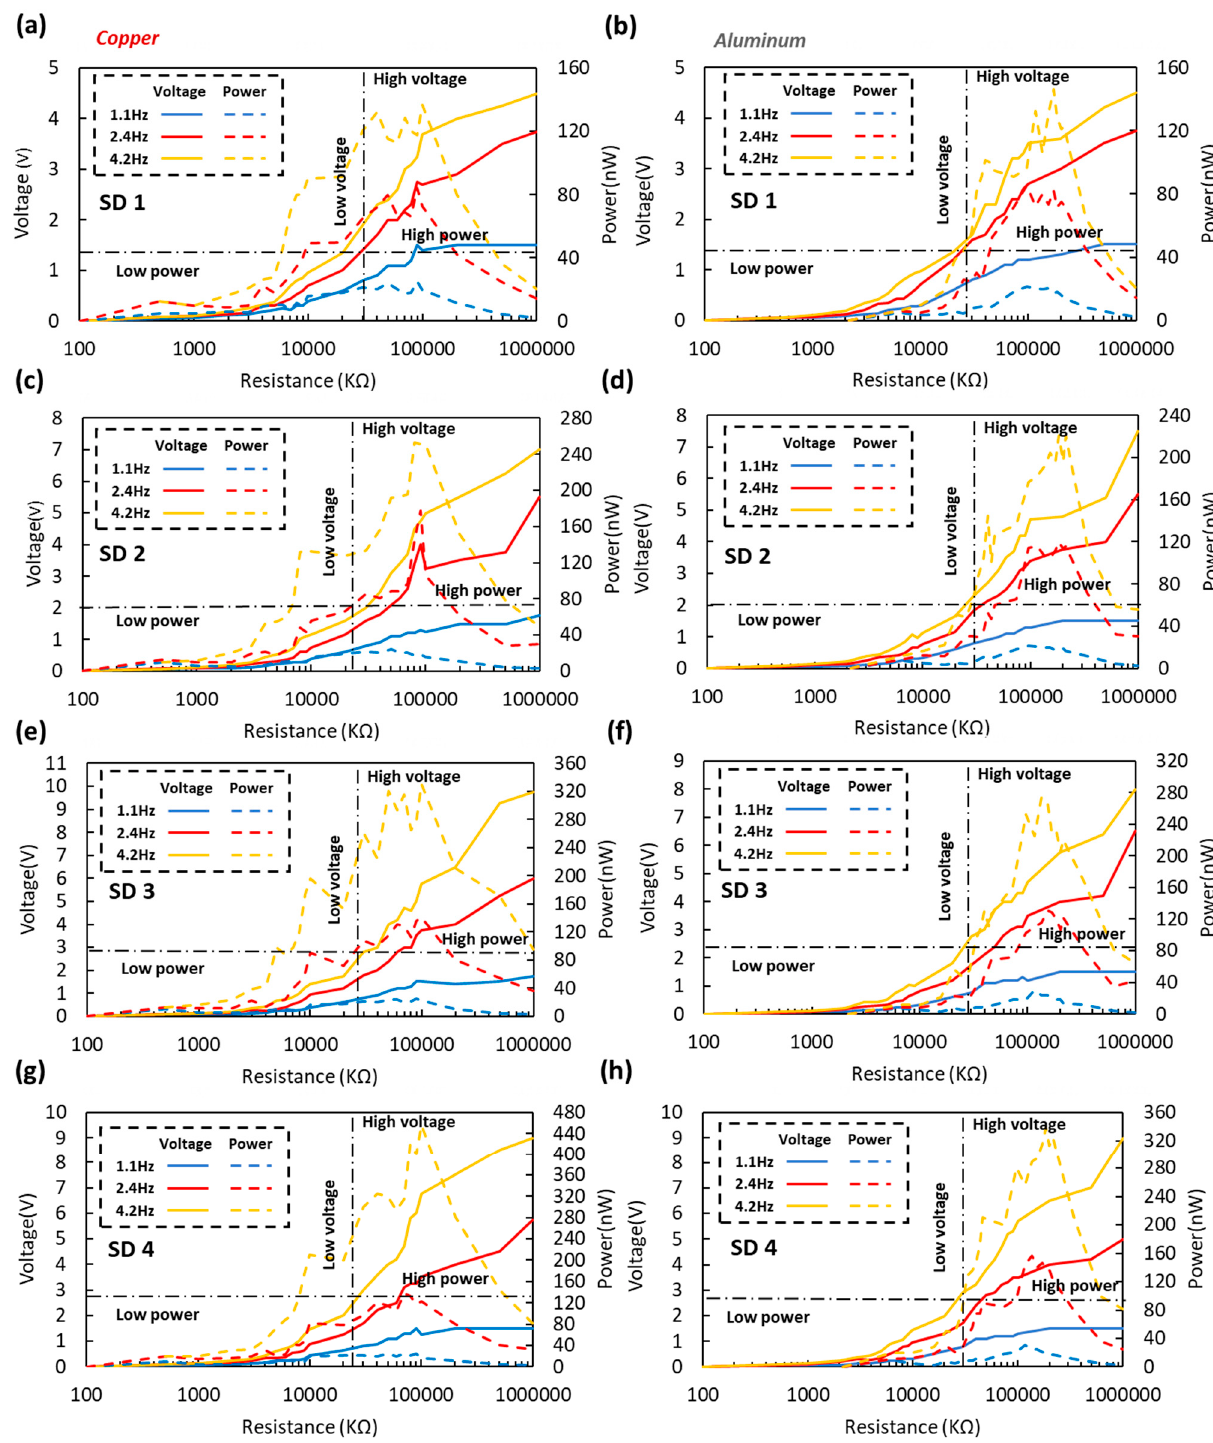
Figure 5. Output performance of RS-TENG with SD1, SD2, SD3 and SD4. Voltage and power distribution trends of the RS-TENG under the loading frequencies of 1.1 Hz, 2.4 Hz and 4.2 Hz in ( a ) copper (Cu) and ( b ) aluminum (Al) in SD 1, ( c ) copper (Cu) and ( d ) aluminum (Al) in SD 2, ( e ) copper (Cu) and ( f ) aluminum (Al) in SD 3, and ( g ) copper (Cu) and ( h ) aluminum (Al) in SD 4.